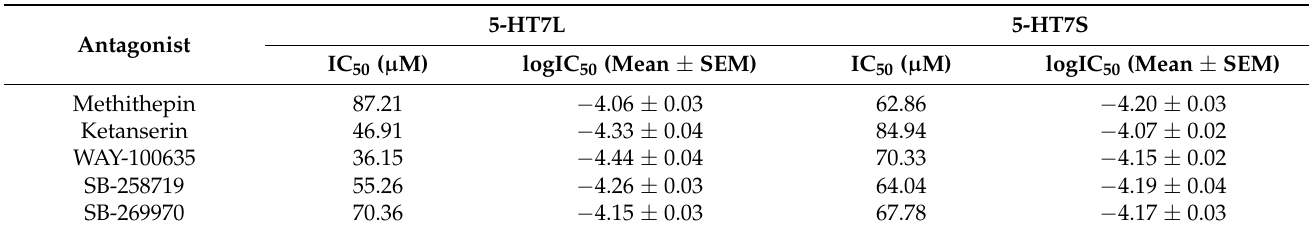
Table 2. IC 50 values of antagonists against two Msep5-HT7 receptor isoforms activation on HEK-293 cells.